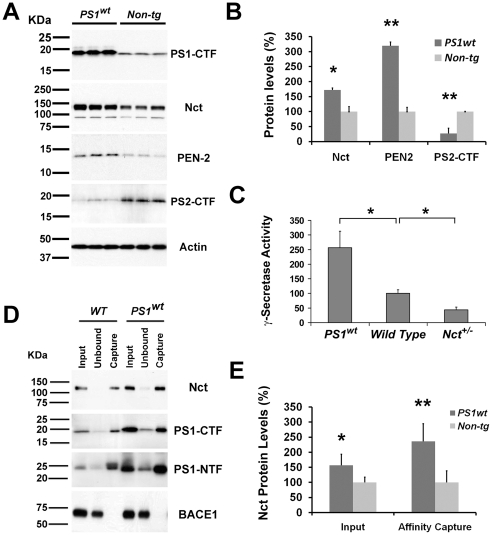
Increase of γ-secretase activity in brains of PS1 mice.(A) Protein extracts (20 µg each) from brains of PS1 transgenic (lanes 1–3) and non-transgenic mice (lanes 4–6) were immunoblotted with anti-sera specific to Nct, PS1-CTF, PEN2, PS2-CTF, or Actin. (B) Quantification of signals of Nct, Pen-2, and PS2-CTF in protein blots by Image J program. The signal density was normalized using Actin signals derived from the same blot. (C) In vitro γ-secretase assay of brain extracts of wild type, PS1 transgenic, and Nct+/− mice. The data were average from 4 samples. (D) The CHAPSO solubilized membrane proteins from wild type and PS1 transgenic mice were incubated with Compound 4 followed by precipitation with streptavidin-coupled beads. Solubilized membranes before ligand addition (Input: 10% of total), captured fraction (Capture: 20% of total) of the affinity ligand and the corresponding supernatants after capture (Unbound: 7.5% of total) were analyzed by Western blot using antisera specific to Nct, PS1-CTF, PS1-NTF, or BACE1. (E) Quantification of signals of Nct levels from in protein blots by Image J program. The signal density was normalized using BACE1 signals derived from the same blot.